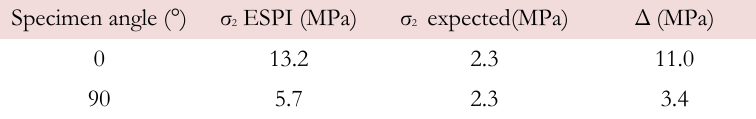
Table 4: Results of the measurement of the minimum principal stress, σ 2 , at 0.4 mm.